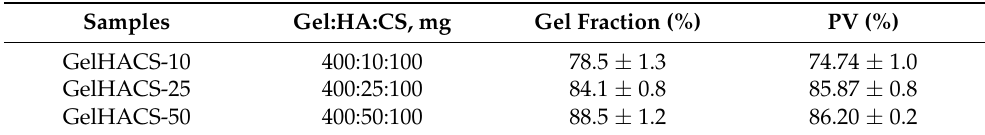
Table 1. The gel fraction and pore volume of cryogels.